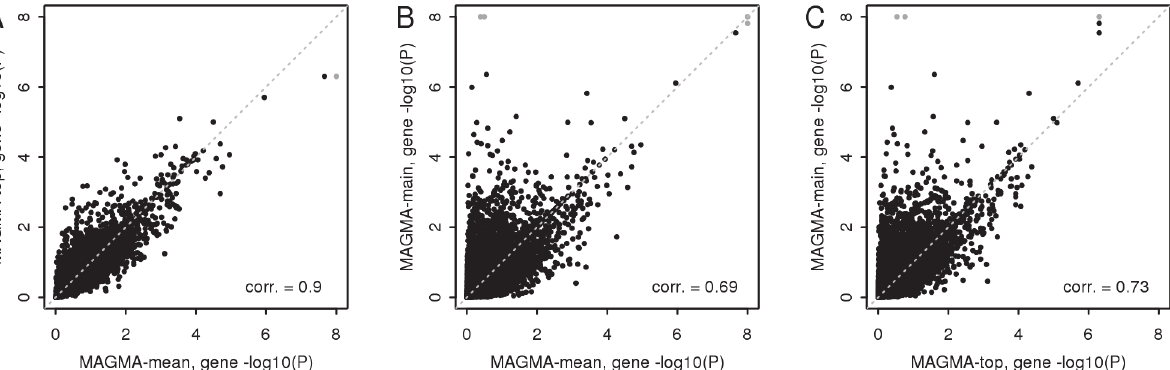
Fig 1. Comparison of gene analysis results for different test-statistics. Gene − log10 p-values from the CD data gene analysis in MAGMA for three different gene test-statistics, comparing analyses using (A) the mean χ 2 statistic with the top χ 2 statistic, (B) the mean χ 2 statistic and the PC regression model and (C) the top χ 2 statistic and the PC regression model. P-values below 10 – 8 are truncated to 10 – 8 (grey points) to preserve the visibility of the other